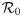
Level sets as a function of FPSP period T and with constant duty cycle DC = 2 / 7.(Left) Changing R0 in [1, 4.4]. (Centre) Changing quarantine effectiveness q in [0, 1]. (Right) Changing compensatory factor d in [0, 1].